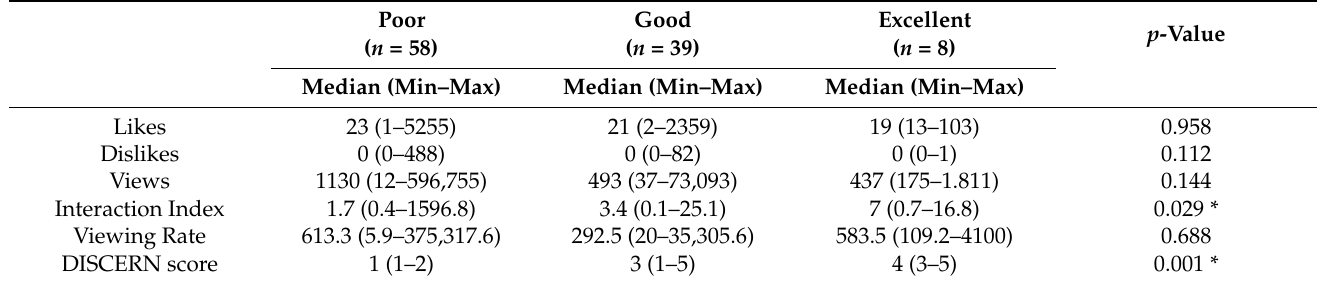
Table 4. Analysis of video variables based on the total video